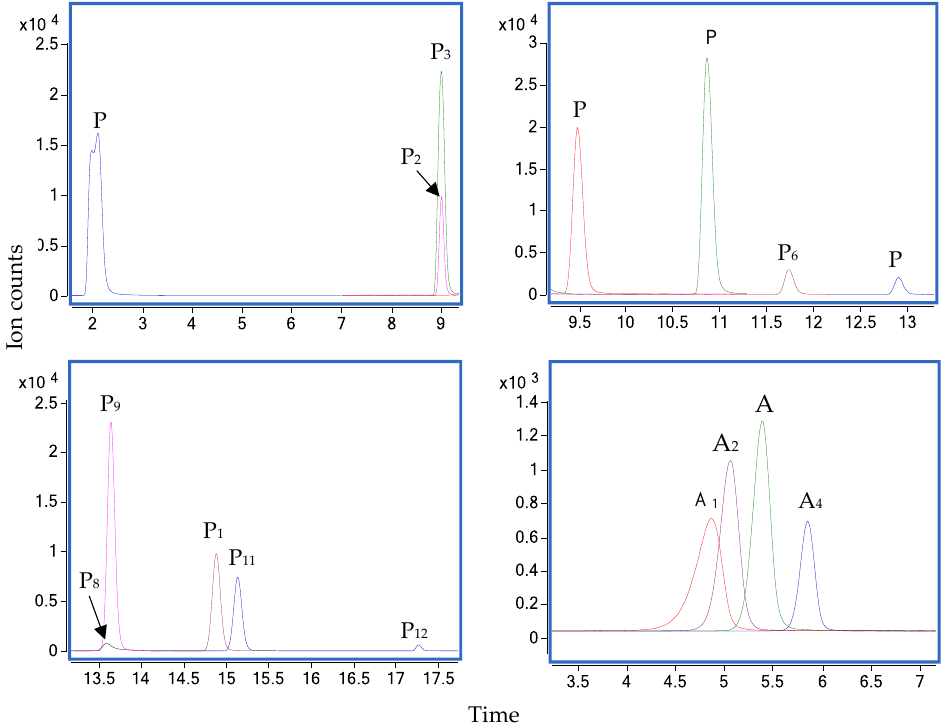
(min) Figure 1. Multiple reaction monitoring (MRM) chromatograms of 12 phenolics (P) and 4 anthocyanins